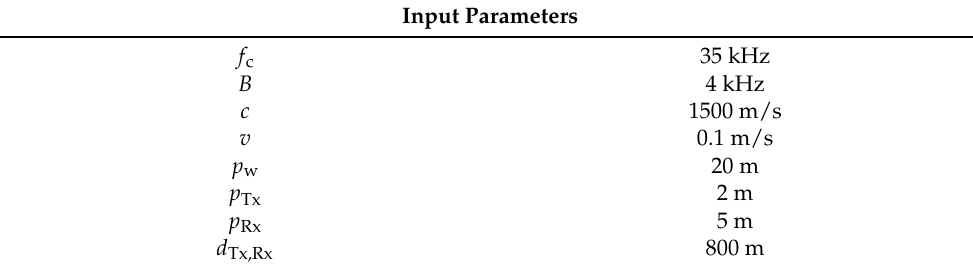
Table 3. BCH1 channel conditions used for the